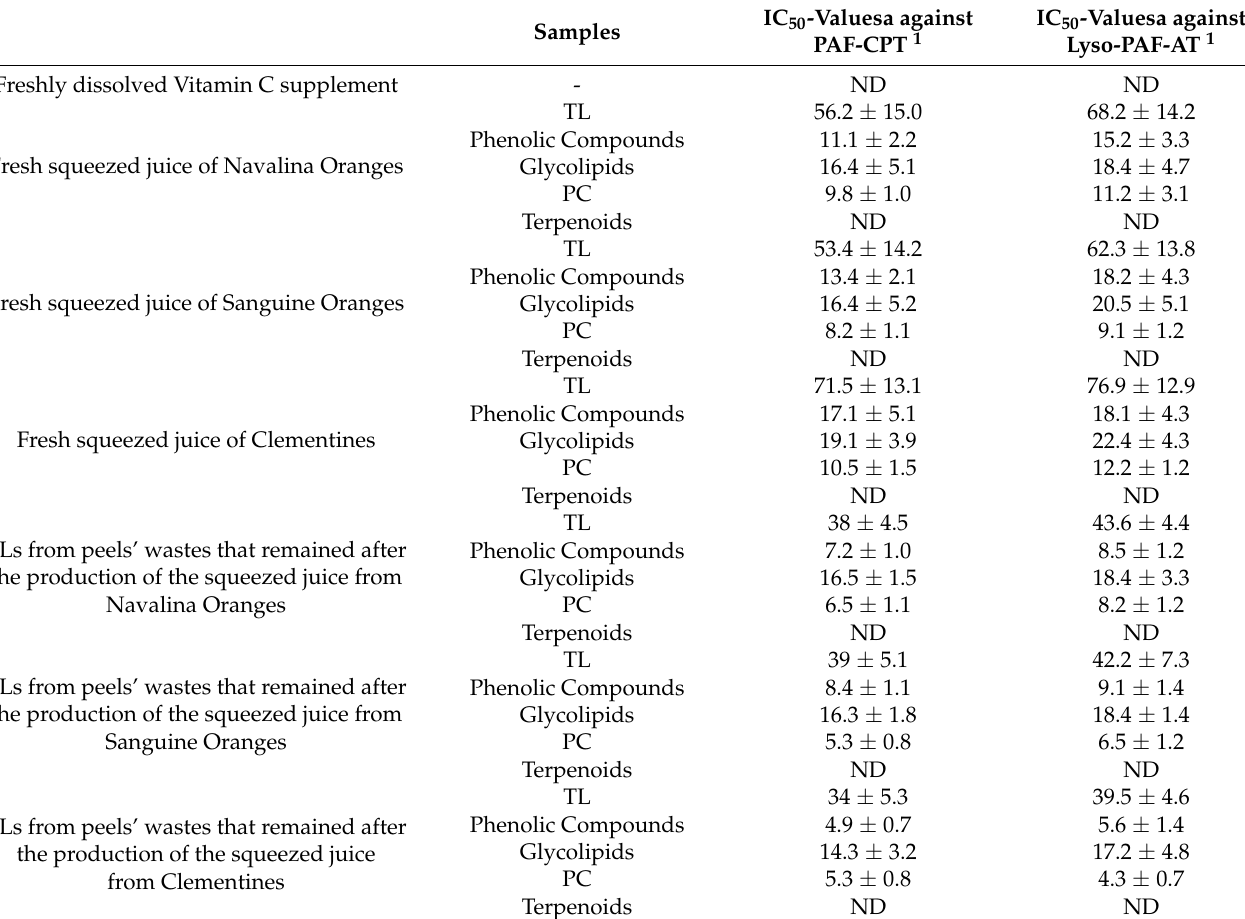
Table 3. In vitro bioactivities (inhibitory effects) of the TL extracts from fresh squeezed juices of Navalina and Sanguine oranges and clementines and their by-products (peels’ wastes), as well as of their most bioactive HPLC-derived lipid fractions, against the specific activities of the basic biosynthetic enzymes of PAF (PAF-CPT and Lyso-PAF-AT) in rabbit leukocytes. Enzyme assays were performed several times to ensure